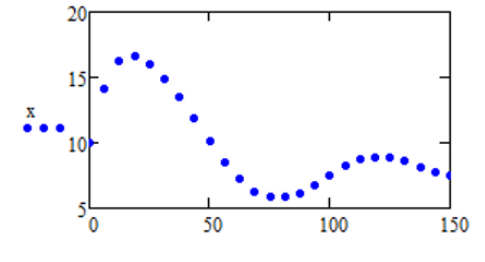
Fig. 1. Graph of solution x = x ( t )